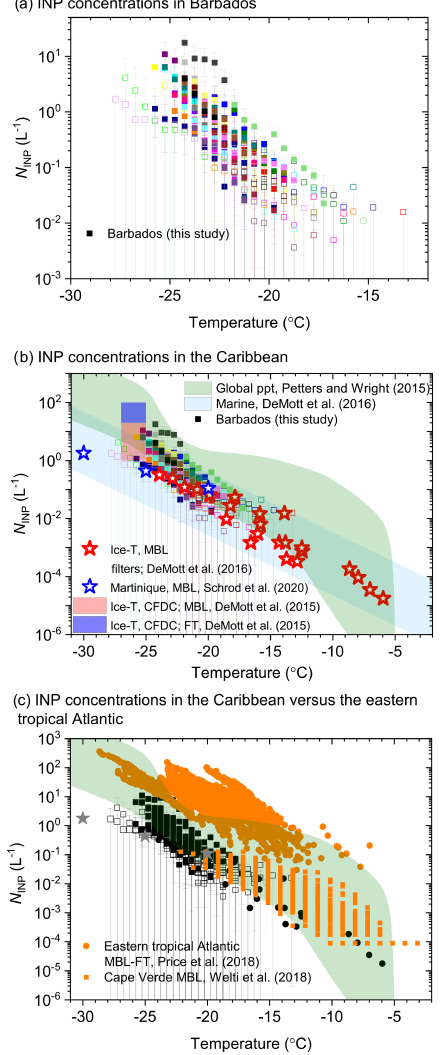
Figure 4. INP concentrations in Barbados and the tropical Atlantic. (a) Compilation of INP concentration spectra from Barbados from the 24 July–24 August 2017. See Table S1 where the data point colour is linked to the sampling period. Data points which were con- sistent with the background signal are displayed as hollow points and are upper limits (see Text S1). The uncertainty on the µL-NIPI instrument is estimated to be 0.4 ◦ C (Whale et al., 2015). (b) INP concentrations in the MBL of Barbados compared to other mea- surements in the Caribbean (DeMott et al., 2015, 2016; Schrod et al., 2020), as well as the range of INP concentrations derived from precipitation samples around the globe (Petters and Wright, 2015) and a representation of INP concentrations from marine locations and wave tank experiments (DeMott et al., 2016). The range of re- ported INP concentrations, at a set of temperatures, measured using a continuous flow diffusion chamber (CFDC) in the marine bound- ary (MBL) layer and free troposphere (FT) of the Caribbean are presented as the shaded red and blue regions (DeMott et al., 2015). (c) The Caribbean INP concentrations compared with the available measurements in the eastern tropical